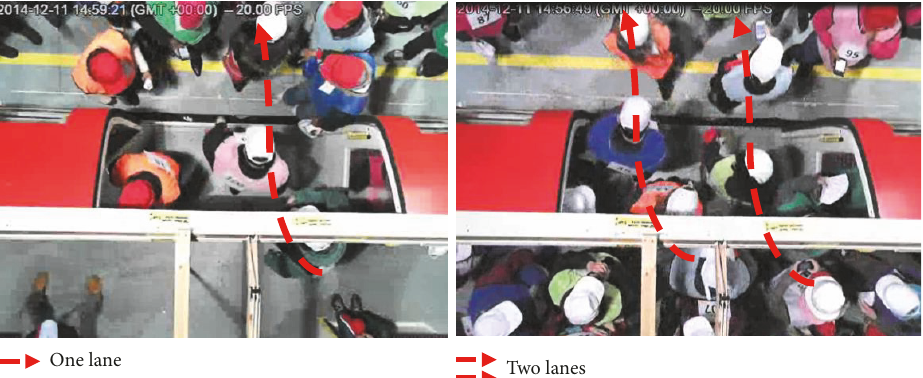
Figure 7: Example of formation of lanes of flow for alighting passengers. One narrow lane of flow when R = 4 (left) and two lanes of alighting flow when R = 0.25 (right) in crowded